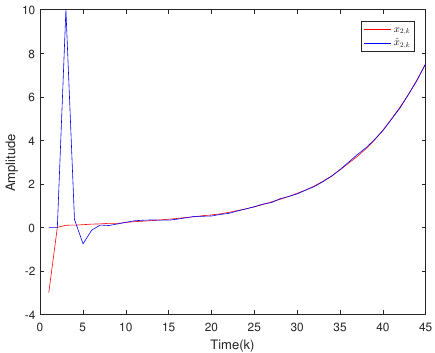
Figure 3. The state evolutions of x 2, k and corresponding estimates ˆ x 2, k